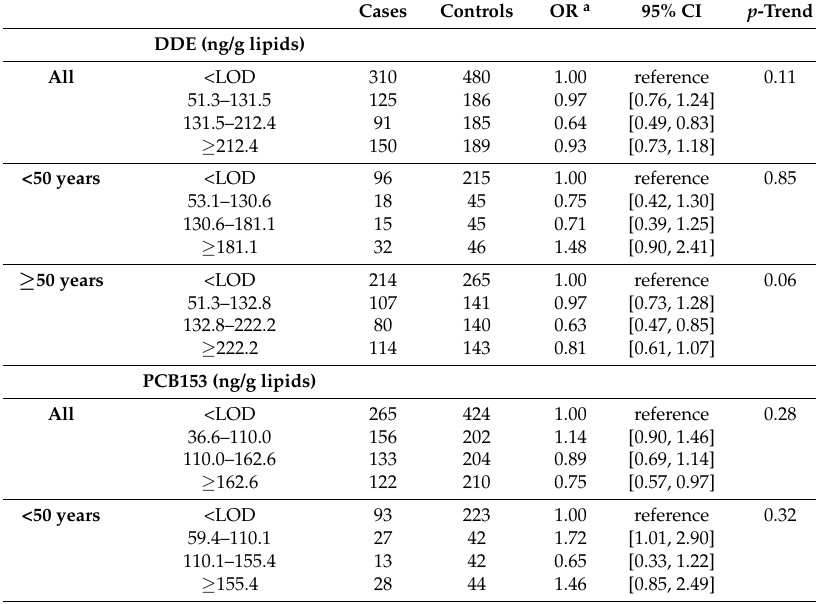
Table 3. Odds ratios of breast cancer for plasma DDE and PCB153 concentrations measured at diagnosis for the cases and the matched controls of the CECILE